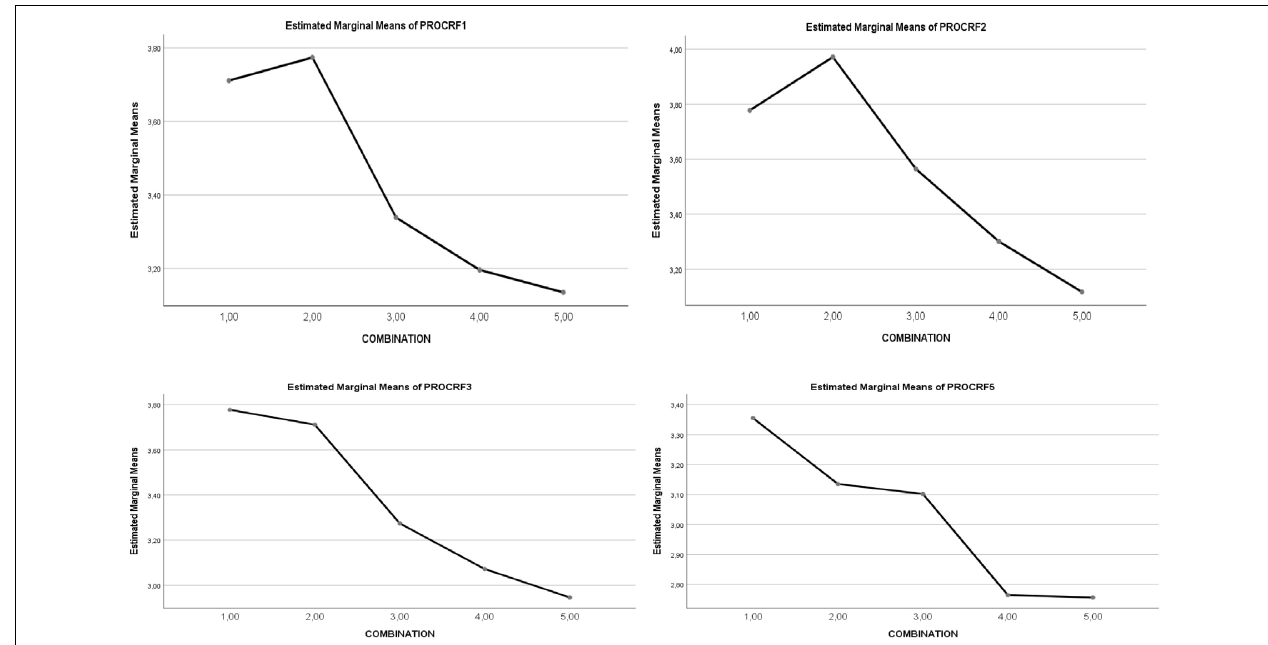
FIGURE 4 | Graphical representation of the effect of combination types (1–5) on procrastination activities. Procrastination activities: F1. TERM PAPERS; F2. STUDY FOR EXAMS; F3. WEEKLY READING; F4. ADMINIST. TASKS; F5. ATTENDANCE; F6. ACTIV. IN GENERAL.